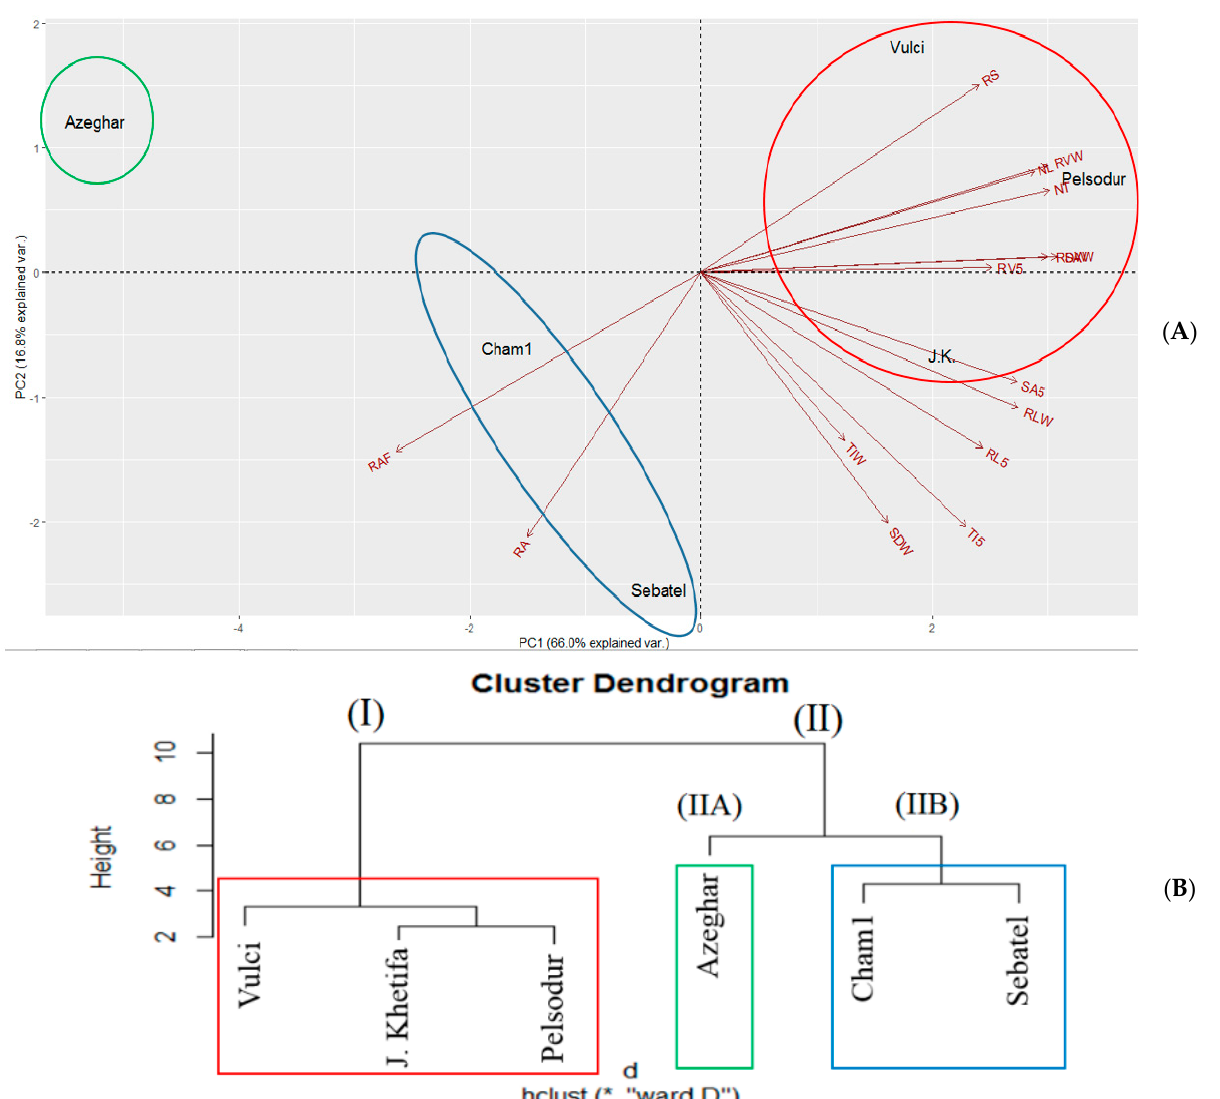
Figure 8. Principal component analysis ( A ) and hierarchical cluster dendrogram applying Ward’s method ( B ) of the six investigated durum wheat genotypes under drought conditions. NL—number of leaves; NT—number of tillers; SDW—shoot dry weight; RVW—total root volume; RLW—sum of all root lengths; TIW—total number of tips; RDW—root dry weight; SAW—total root surface area; RS—root shoot ratio; RL5—sum of root lengths in the first 5 cm below the ground; SA5—root surface area in the first 5 cm below the ground; TI5—number of tips in the first 5 cm below the ground; RV5—root volume in the first 5 cm below the ground; RA—root angle of plants grown in greenhouse under drought conditions; RAF—root angle of plants grown in the field. * indicates significance at p < 0.05.